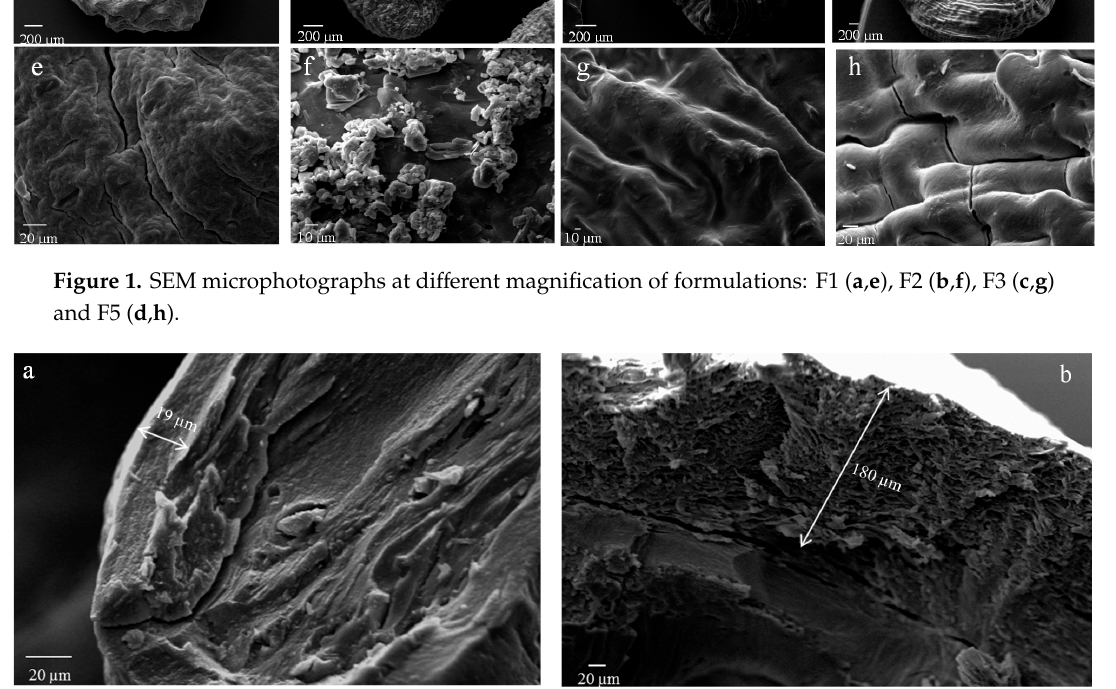
Figure 2. SEM microphotographs of cryofractured core/shell beads: F4 ( a ) and F5 ( b ).